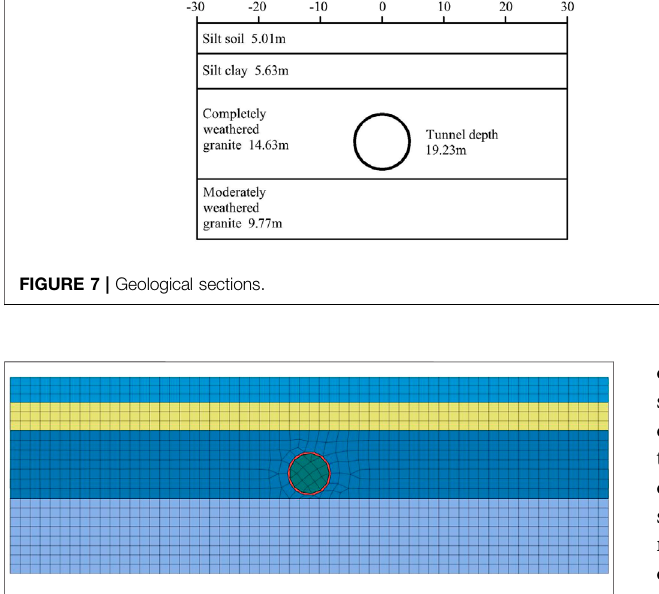
FIGURE 8 | Finite element model.